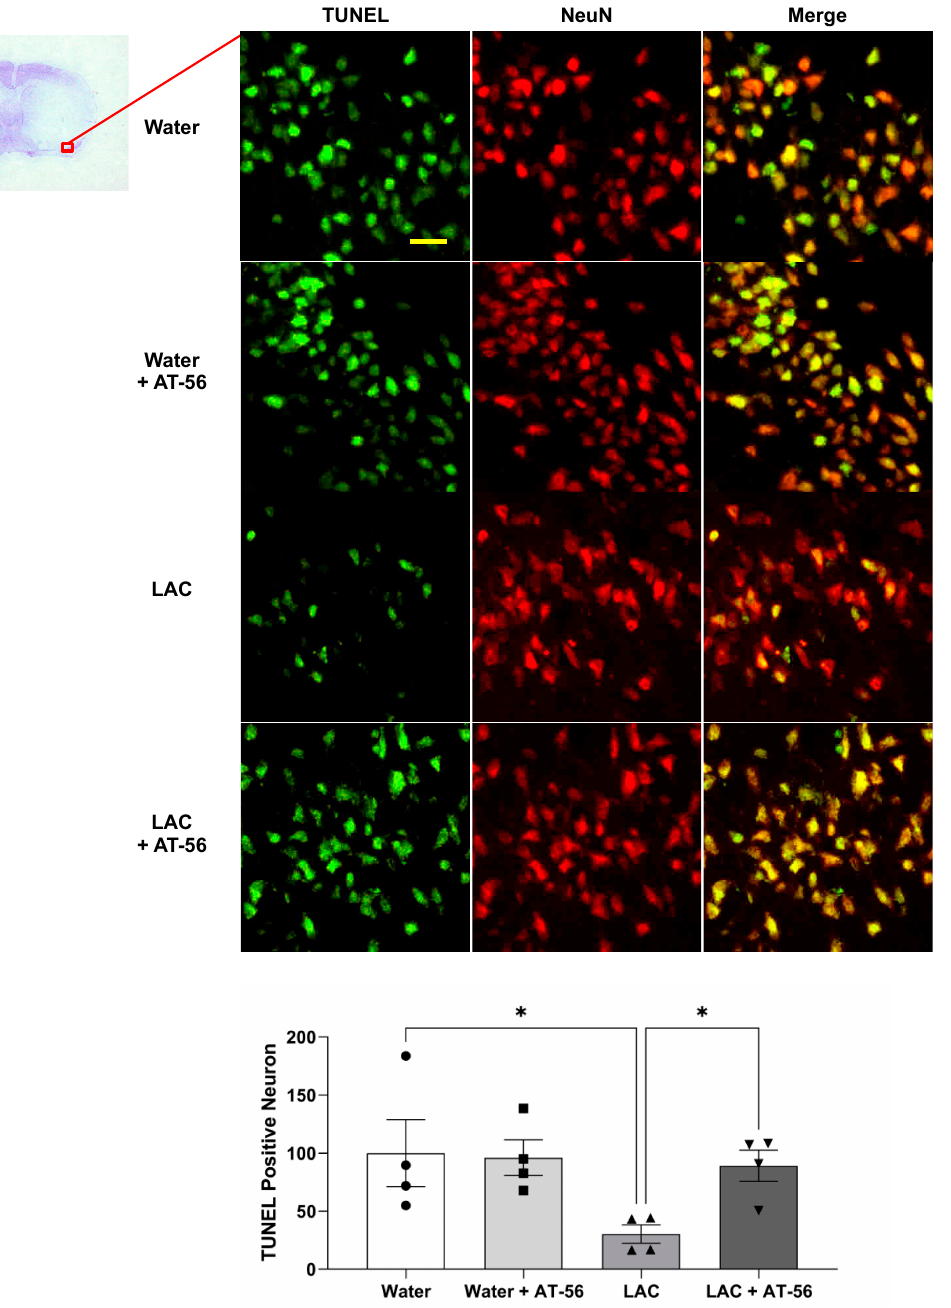
Figure 4. Effect of AT-56 on TUNEL-positive neurons in the cerebral cortex following transient focal cerebral ischemia. ( A ) Representative double staining of NeuN and TUNEL in the peri-infarct cortex of the temporal lobe at the section 0.23 mm caudal to bregma. Scale bar = 20 μ m. ( B ) Values of TUNEL-positive neurons are means ± SEM for 4 mice in each group. * p < 0.05. Analyzed using two-way ANOVA followed by Tukey’s test.